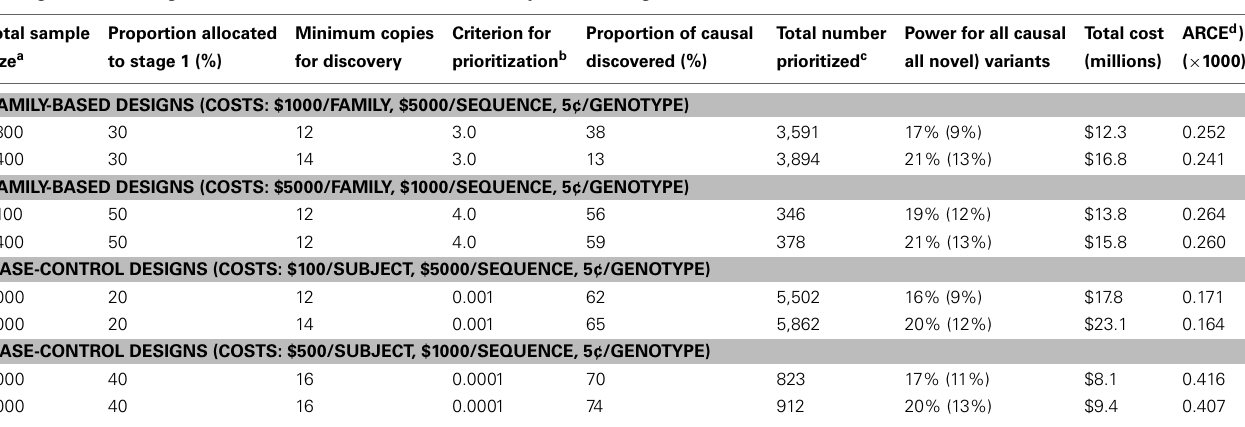
Table 4 | Some near-optimal multi-stage family-based and case-control designs (The first row of each block is the one with the highest ARCE among those investigated; the second is the one with better power among those with similar